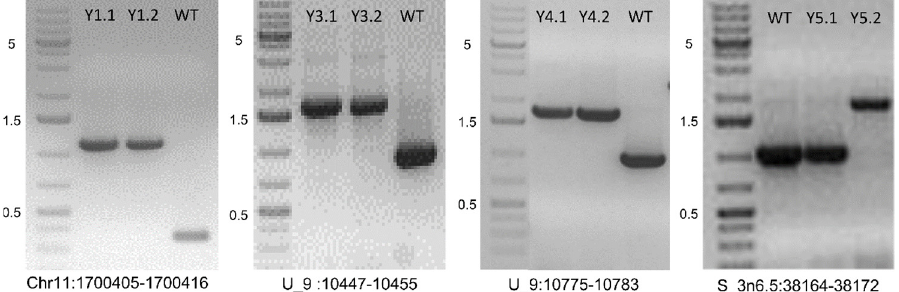
Figure 2. Validation of small Hornet transposon insertion events detected in experimentally evolved populations of Fol4287. PCR was performed with primers flanking the insertion site in the ancestor strain (WT) and two single spore (SS) isolates in populations Y1, Y3, Y4, and Y5, respectively. GeneRuler 1 kb Plus DNA Ladder shown with indicated sizes in kb to the left. Specific primers designed for validation of TE insertion events are Y1 forward: TCCTCCTGGGTTTCTTGTCAC, Y1 reverse: CTCTTGAAACGTGGTGCAGAC; Y3 and Y4 forward: AGACGGACAAAGAGGTGTGAC, Y3 and Y4 reverse CTCGACACTACCAGGCACTAT; Y5 forward: GAGTATGCTTCCCGATCCTTG, Y5 reverse: GACATCCCTCAATCCGCTGAA.